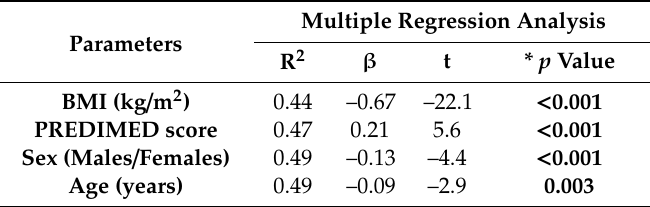
Table 6. Multiple regression analysis models (stepwise method) with the 25OHD level as the dependent variable to estimate the predictive value of PREDIMED score, sex, age, and BMI.